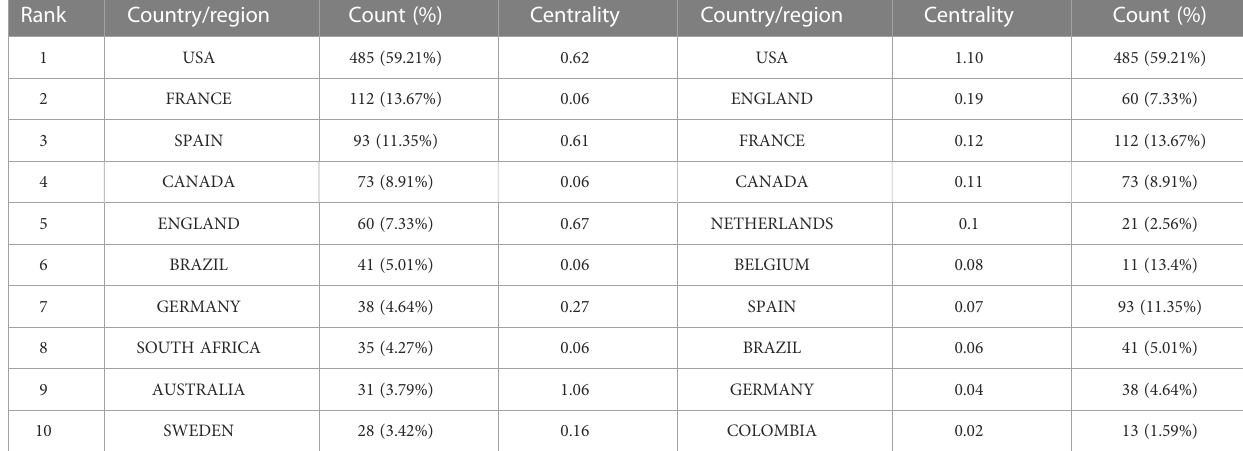
TABLE 1 The top ten countries/regions with the most publications quantity (center sides) and betweenness centrality (right sides). Rank